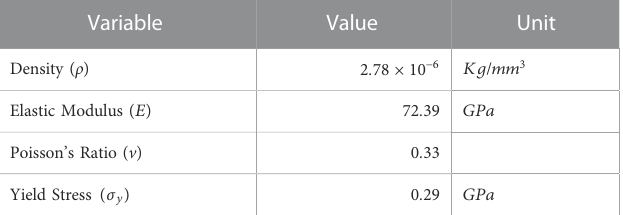
TABLE 4 Material property of Al 2024-T3 (Chen & Ingraffea, 2002).